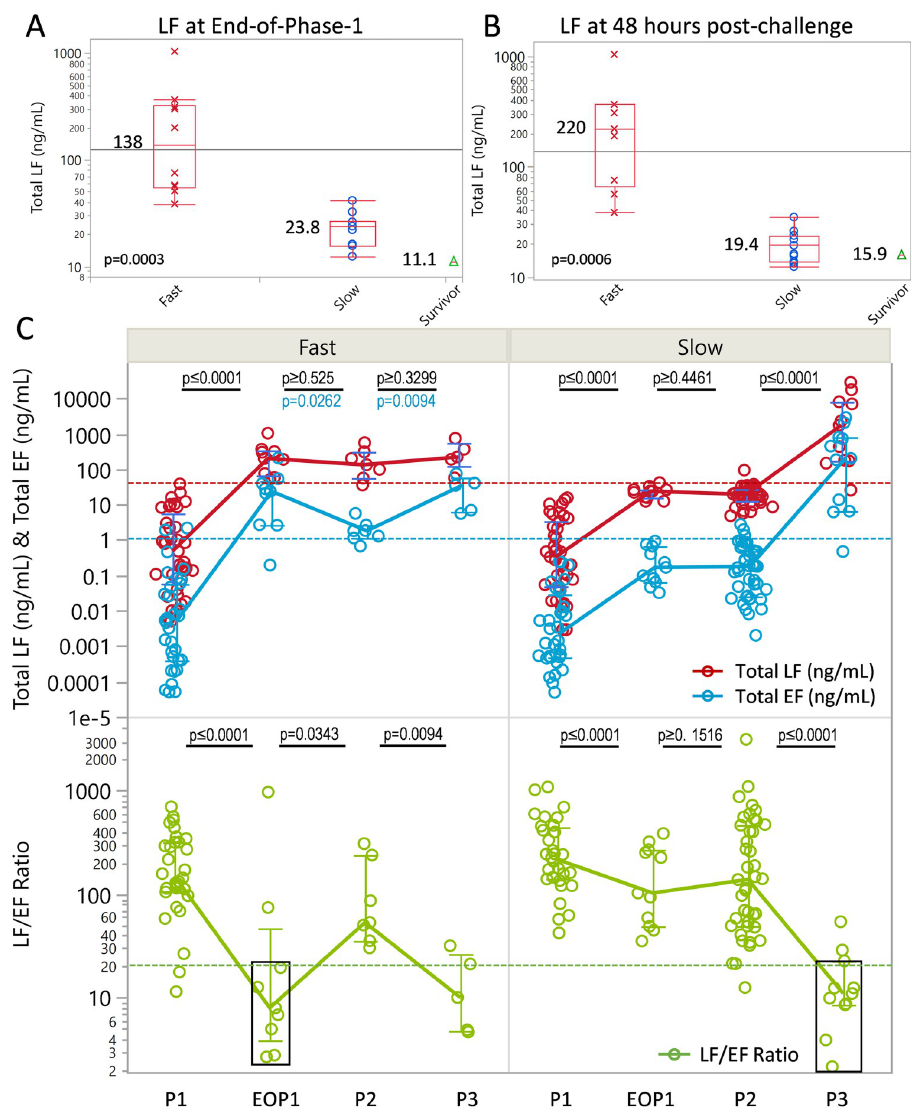
Fig 4. Stage-dependent biomarker levels. Lethal factor levels in animals with fast and slow progression, and survivor, at the end-of-phase-1 (A) and 48 hours (B). Box plot is for median and quartiles, error bars for minimum and maximums, excluding outliers, median levels and p-values included for Wilcoxon rank sum test. (C) LF, EF levels (upper panel), and LF/EF ratio (lower panel), during earliest detection in phase-1 (P1), at the end-of-phase-1 (EOP1), subsequent phase-2 (P2), and phase-3 (P3) for fast progression (left panel) and slow progression (right panel). Lines connect the medians and error bars give quartiles for each stage. Red dashed line represents the LF threshold and blue line the EF threshold for phase-2. P-values included for testing differences in toxin levels and toxin ratios between phases. Black font includes all parameters unless another color font is shown for a specific parameter. Black rectangle shows similarity of low LF/EF ratios at the EOP1 for fast progression and P3 for slow progression.